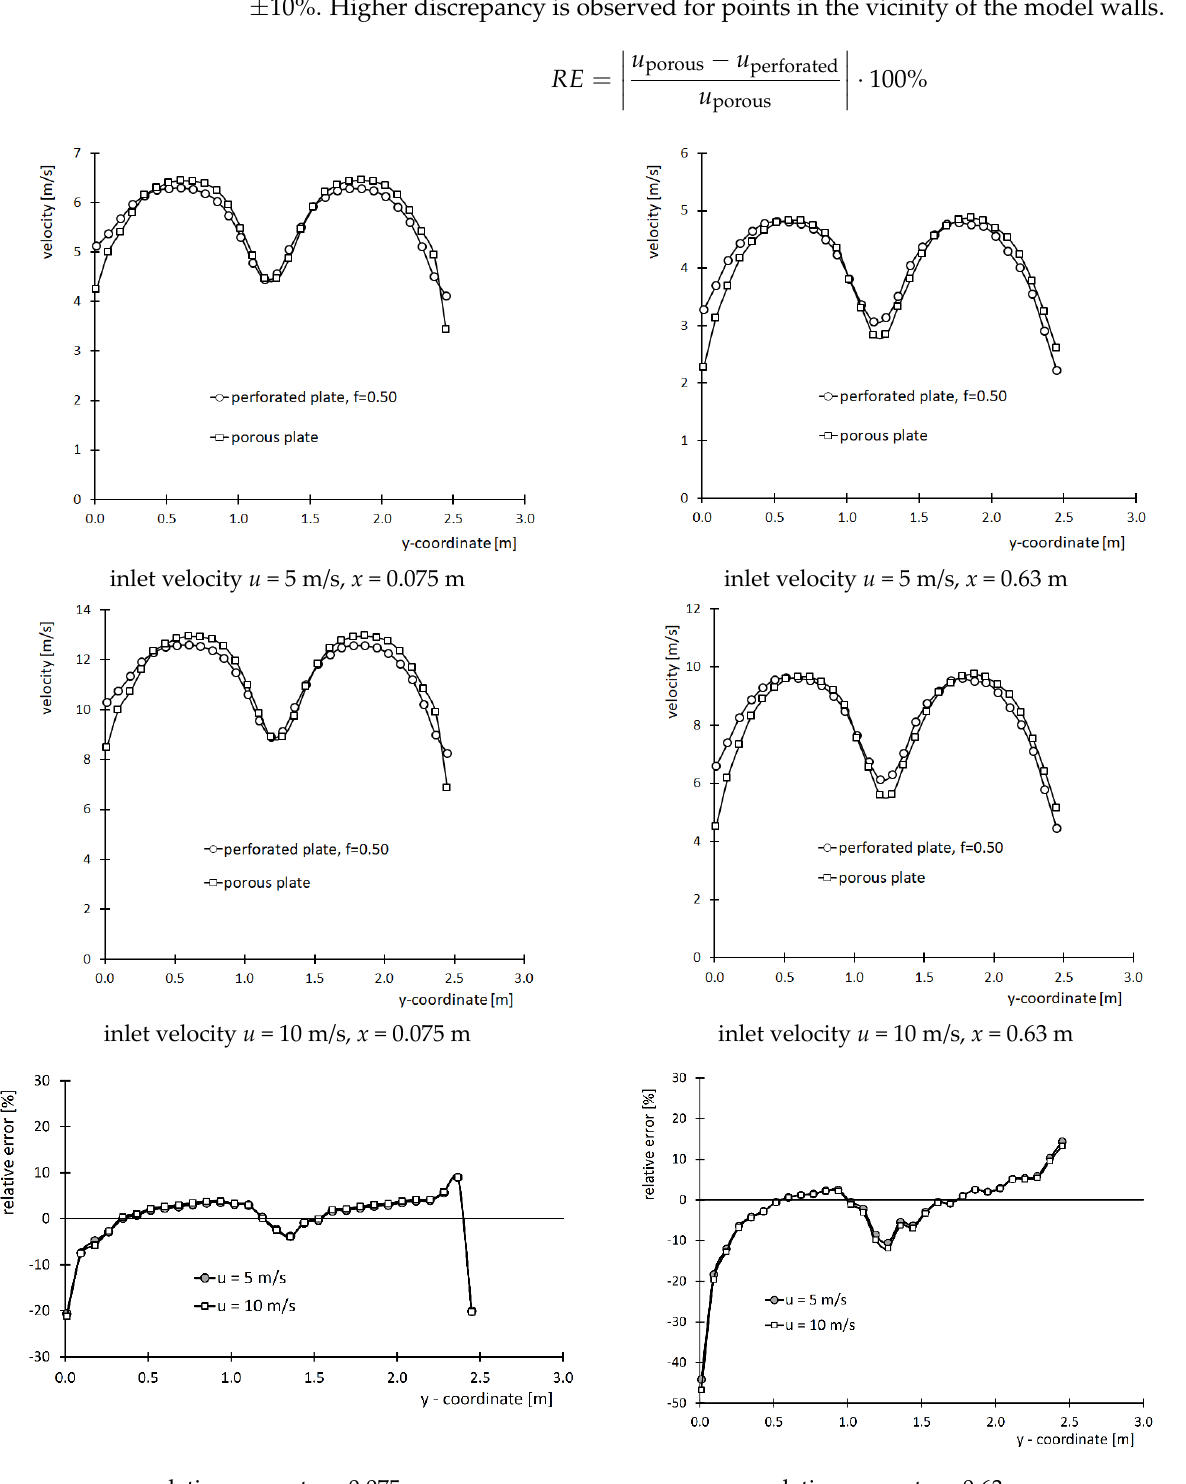
Figure 14. Velocity module profiles at cross-section x, f = 0.50, for inlet velocities 5m/s and 10 m/s.